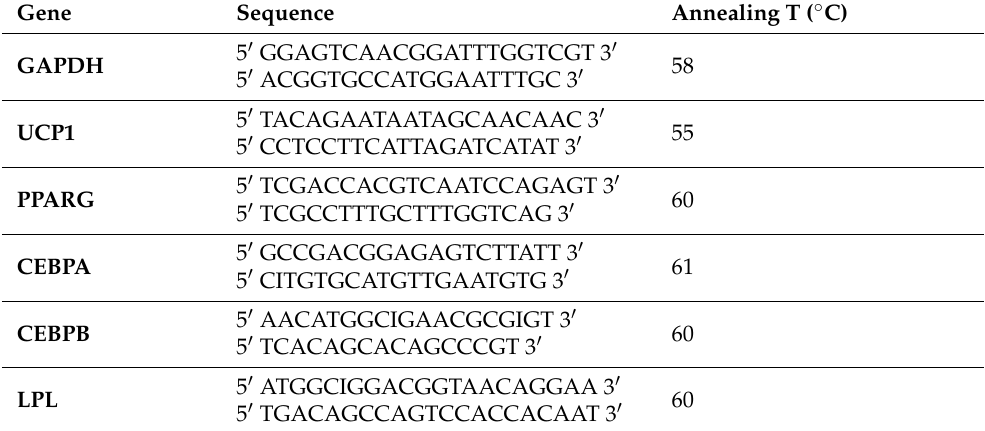
Table 2. RT-qPCR primers